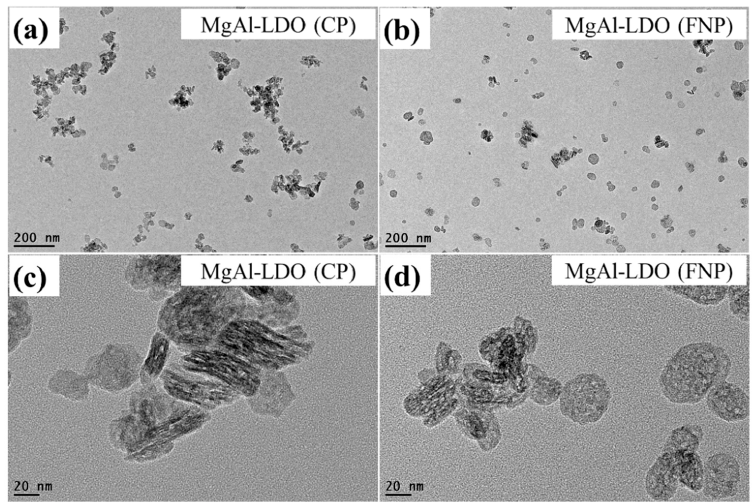
Figure 2. X-ray diffraction (XRD) patterns of MgAl-LDH (CP), MgAl-LDH (FNP), MgAl-LDO (CP), and MgAl-LDO